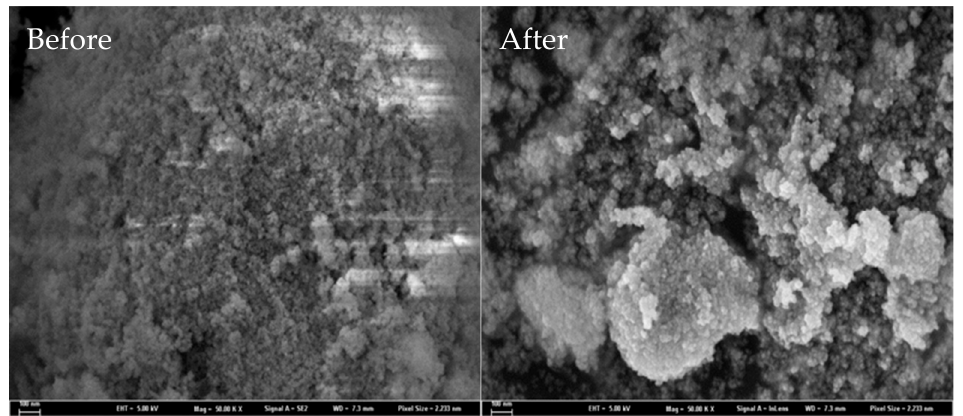
Figure 12. SEM of the Cr-Pt-WZ catalyst before and after the reaction. Magnification of the electron microscope: 10,000.